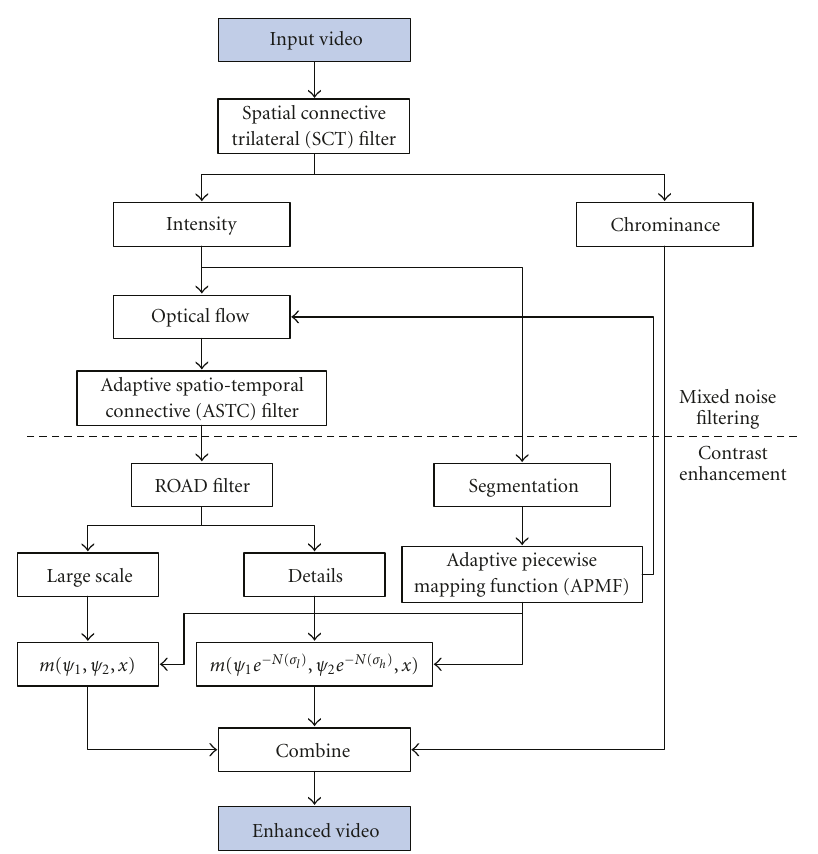
Figure 1: Framework of proposed universal video enhancement system, consisting of mixed noise filtering and contrast enhancement.